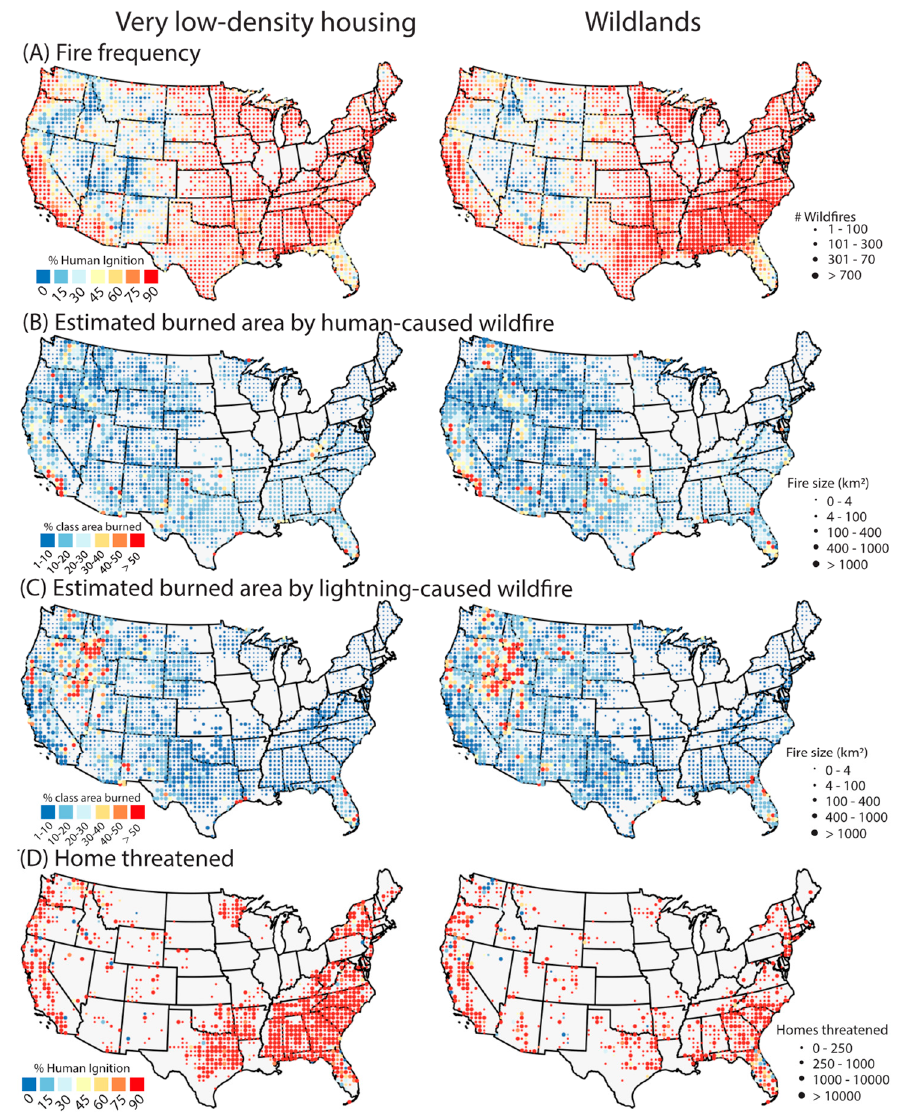
Figure 2. Spatial representation of fire effects in the very-low-density housing and wildlands. ( A ) The total number of wildfires (dot size) stratified by the proportion of wildfires started by humans, ( B ) the total fire size (dot size) as a percentage of each class that was estimated burned by human-started wildfires, ( C ) the total fire size (dot size) as a percentage of each class that was estimated burned by lightning-started wildfires, and ( D ) the total number of homes threatened stratified by the proportion of wildfires started by humans within each 25-km grid cell from 1992–2015. Black lines represent state boundaries. For ( A ) and ( D ), reds indicate a greater proportion of human-started wildfires, while blue indicates a greater proportion of lightning started wildfires.